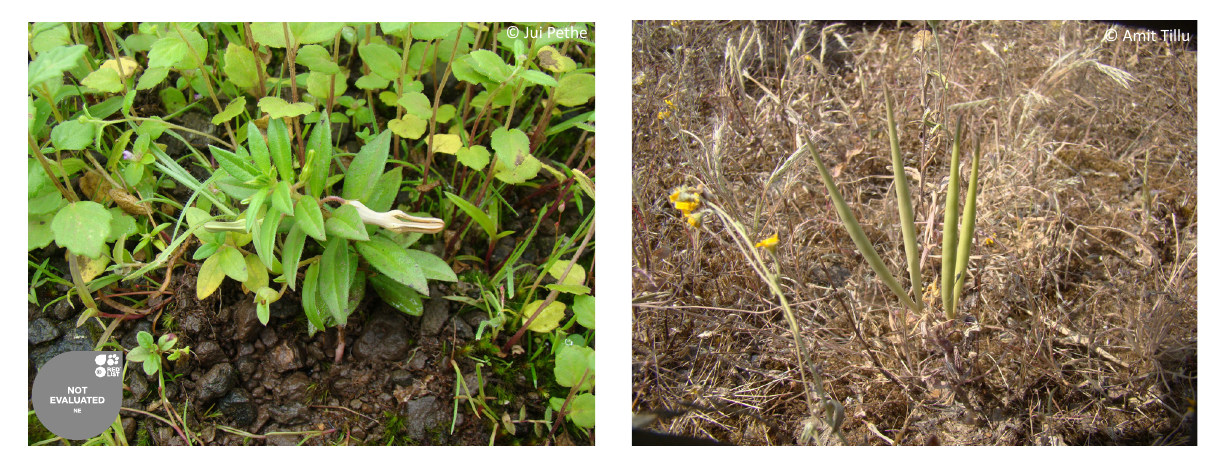
Image 2. Ceropegia anjanerica plant with flower. Image 3. Ceropegia anjanerica follicles on withering plant.